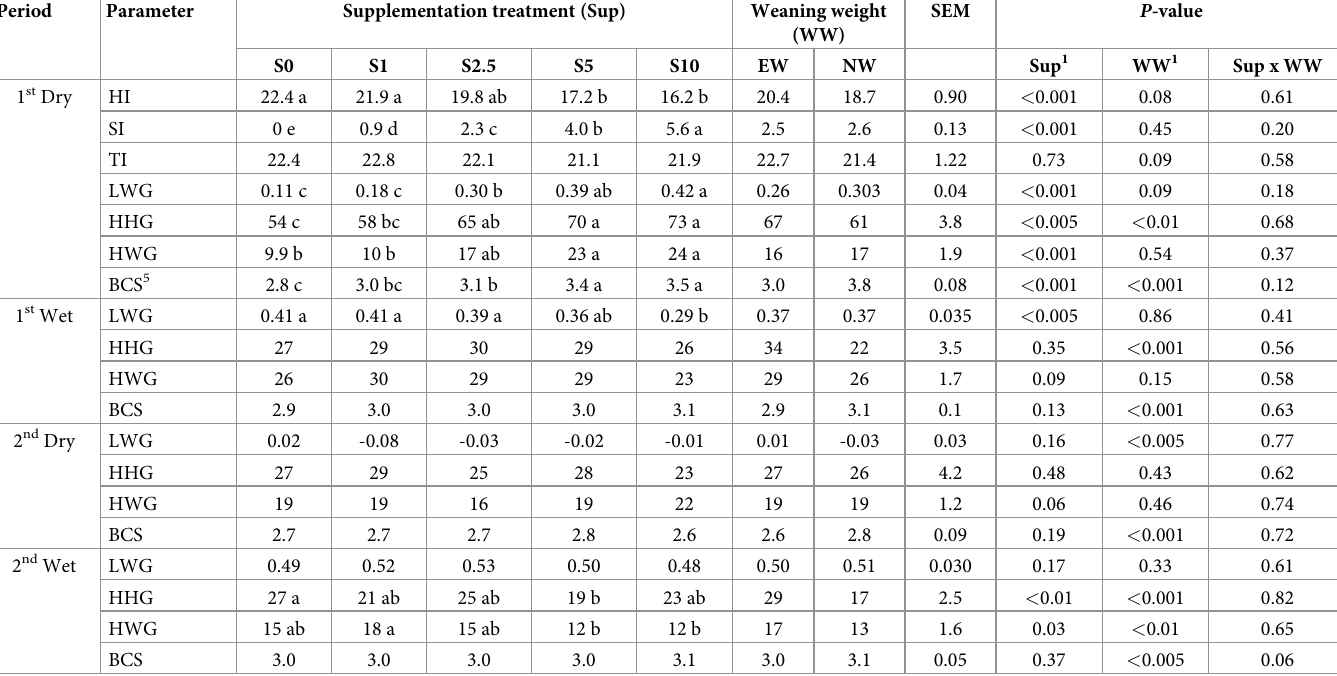
Table 2. Hay (HI), Supplement (SI) and total (TI) intake (g DM/kg LW.day), Liveweight gain (LWG; kg/day), hip height gain (HHG; mm/100 days), hip width gain (HWG, mm/100 days) and body condition score (BCS) of early (EW) and normally (NW) weaned 1 crossbred Brahman heifers fed different levels of post-weaning supplementation 2 over the first dry season 3,4